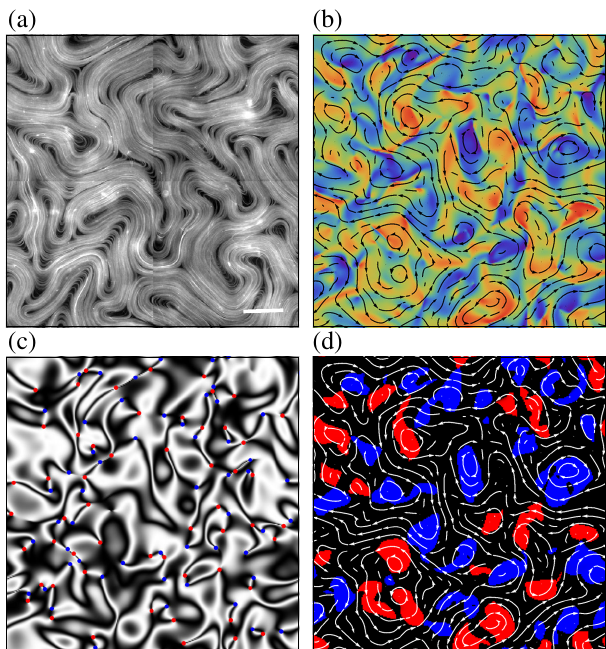
FIG. 1. (a) A two-dimensional active nematic suspension of microtubule bundles and kinesin at the water-oil interface. The white scale bar corresponds to 100 μ m (courtesy of the Dogic Lab). (b) – (d) Numerical simulations of an extensile active nematic obtained from an integration of Eq. (1). (b) Flow velocity (black streamlines) and vorticity (background color). (c) Schlieren texture constructed from the director field n . The red and blue dots mark, respectively, the þ 1 = 2 and − 1 = 2 disclinations. (d) Clockwise rotating (blue) and counterclockwise rotating (red) vortices, detected by measuring the Okubo-Weiss field as described in the